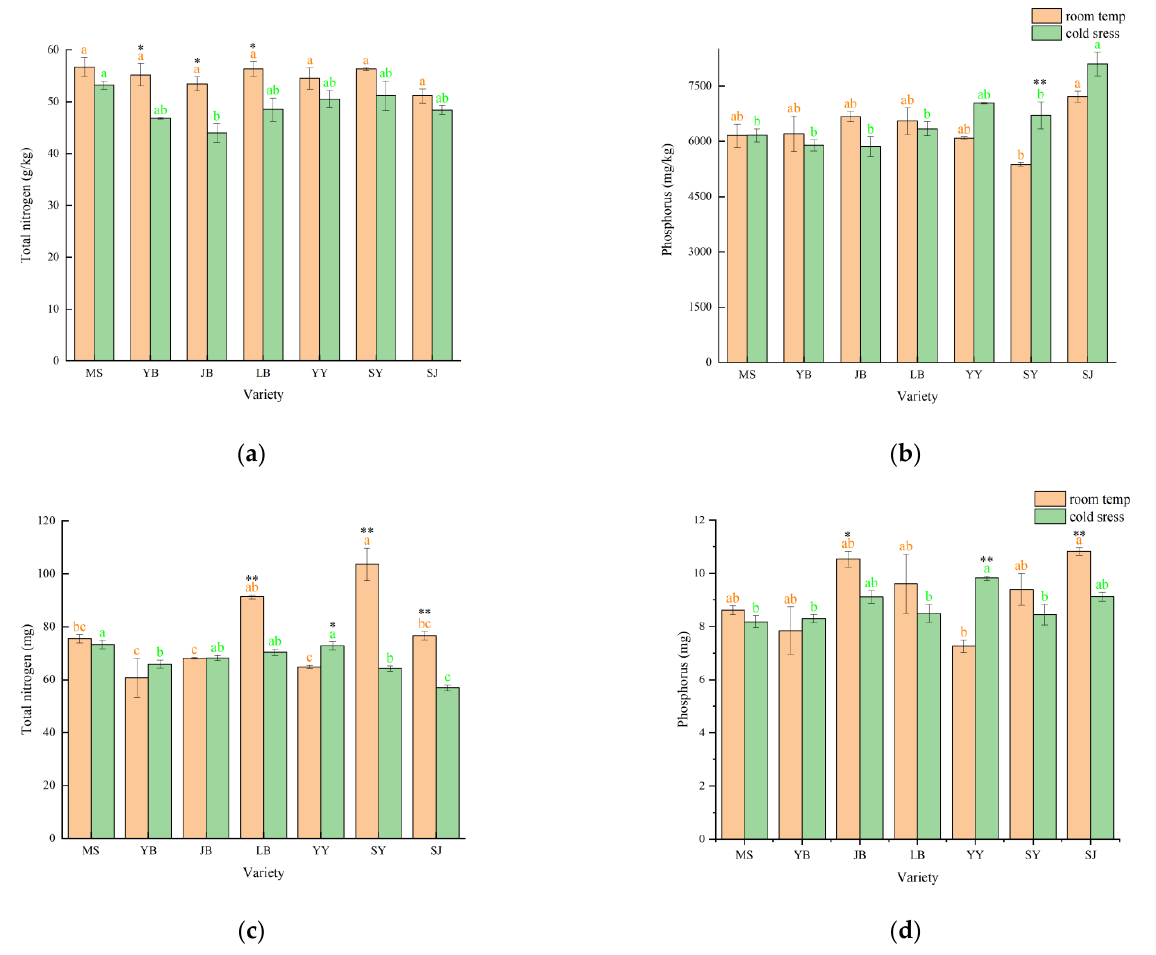
Figure 5. N and P assimilation in O. javanica cultivars at room temperature and under cold stress. Different letters with the same color indicate the significance of the difference in the same temperature. Asterisk indicates the significance of the difference of a different temperature on the same cultivar. * significant differences, p < 0.05; ** extremely significant differences, p < 0.01. ( a , b ) Concentrations of N and P in O. javanica cultivars at room temperature ( a ) and under cold stress ( b ) on day 22. ( c , d ) N and P accumulation amounts in O. javanica cultivars at room temperature ( c ) and under cold stress ( d ) on day 22. MS: ‘Meinan Shuiqin’; YB: ‘Yuqi Baiqin’; JB: ‘Jiangyin Baiqin’; LB: ‘Liyang Baiqin’; YY: ‘Yixing Yuanye’; SY: ‘Suzhou Yuanye’; SJ: ‘Suqian Jianye’.